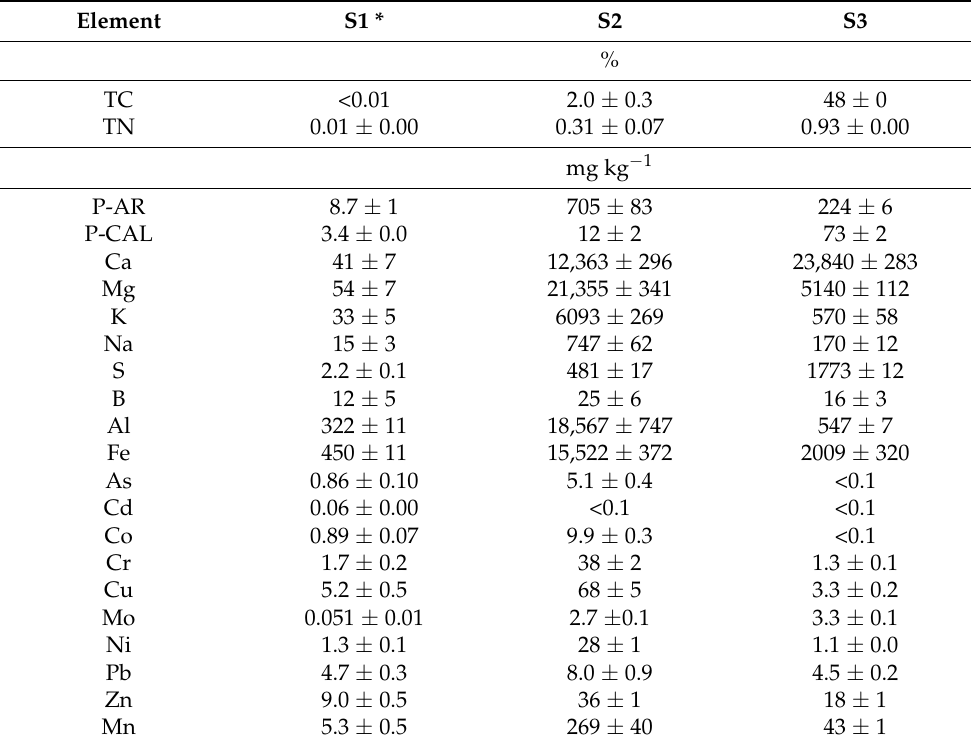
Table 2. Chemical composition of the tested substrates (mean ± standard deviation, n = 8).